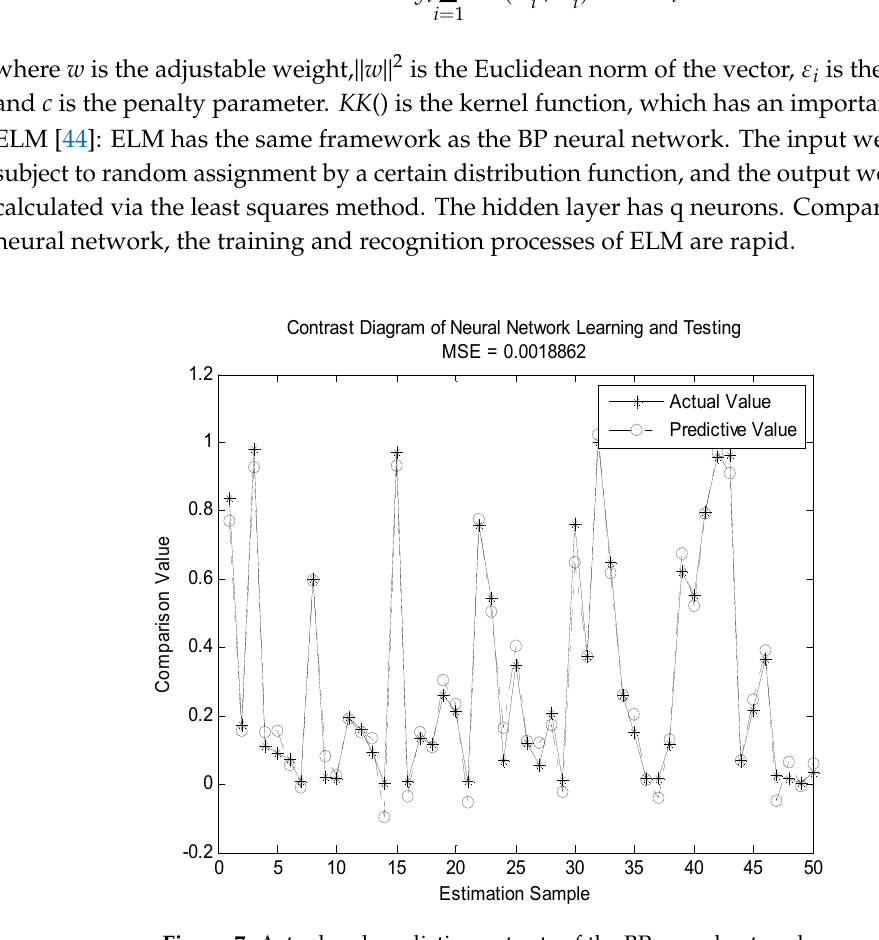
Figure 7. Actual and predictive outputs of the BP neural network.